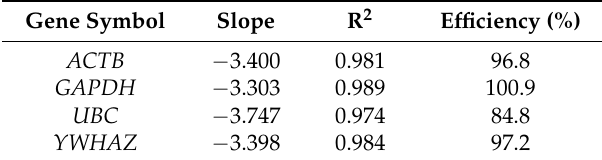
Table 4. Amplification efficiency data for candidate reference genes tested in phase II. Gene Symbol Slope R 2 ACTB